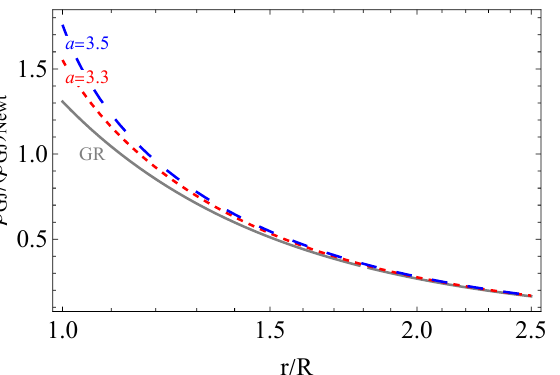
Figure 3. The ratios of the GJ charge density in the frame of EU and GR for different values of the EU parameter a and a fixed value of the compactness of the NS (cid:101) = 0.2 and the inclination angle χ = 0.